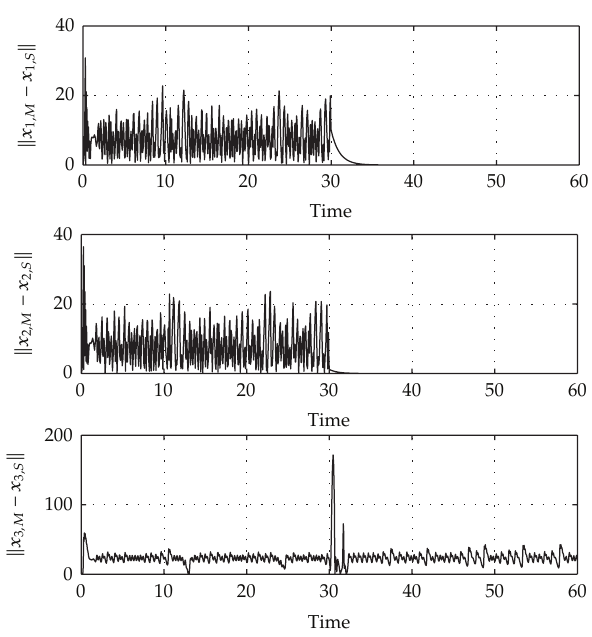
Figure 4: Stabilization of the synchronization error states x 1 and x 2 .